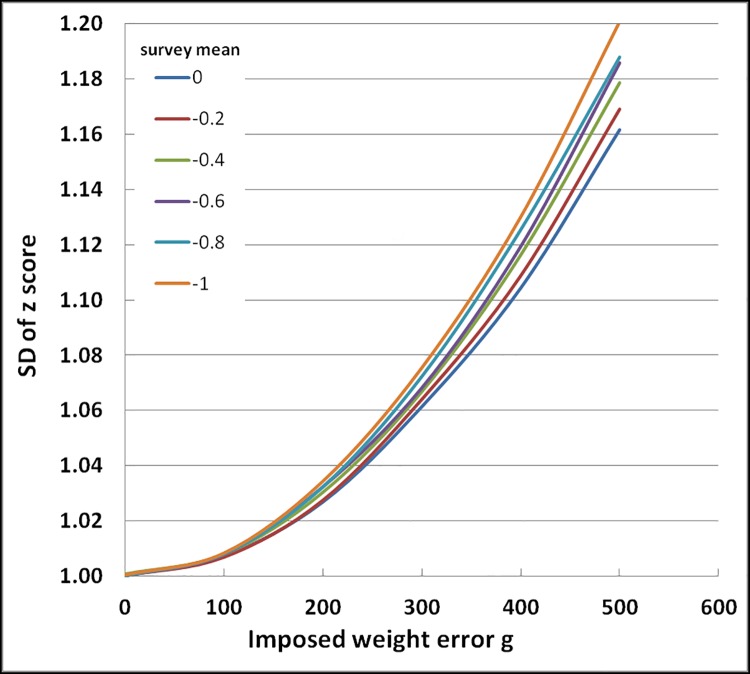
Effect of random error in weight, with no error in height, on the Change in SD of the WHZ distribution from 6 simulated surveys each with different population mean WHZ–Z-scores.The population mean WHZs were 0,-0.2,-0.4,-0.6,-0.8 and -1.0 Z.